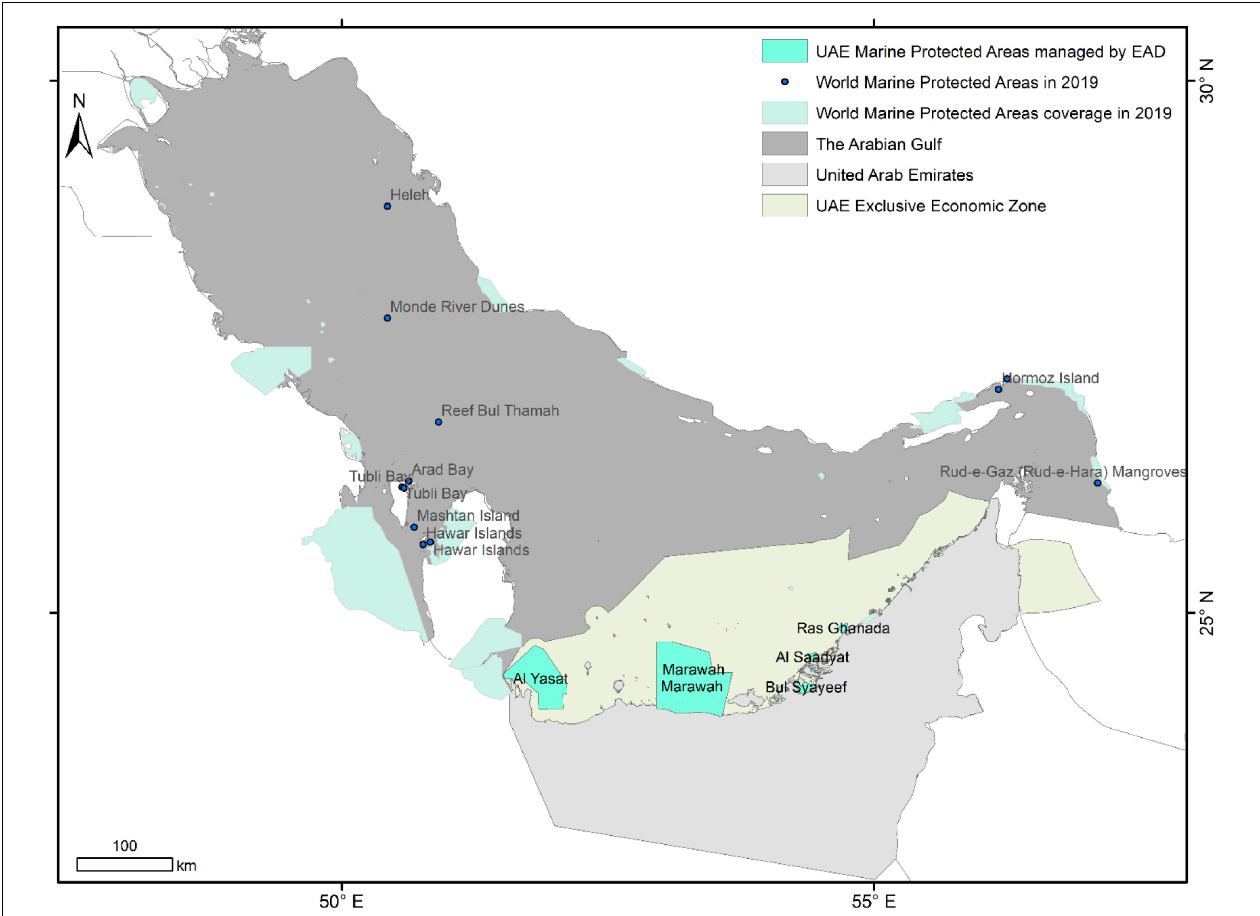
FIGURE 2 | The regional coverage of marine protected areas in 2019. GIS data credit: UNEP-WCMC and IUCN (2019). Protected Planet: The World Database on Protected Areas (WDPA) [On-Line], May 2019, Cambridge, United Kingdom: UNEP-WCMC. GIS data are available at www.protectedplanet.net. The region is known to be under exponential stress due to the high concentration of fossil fuel-related activities; large numbers of offshore installations; tanker loading terminals and exceptionally high oil tanker traffic. Additional over-arching issues facing the region: the introduction of pollutants, physical alteration and destruction of habitats, invasive species and over-exploitation of marine resources (Habib-Mintz,